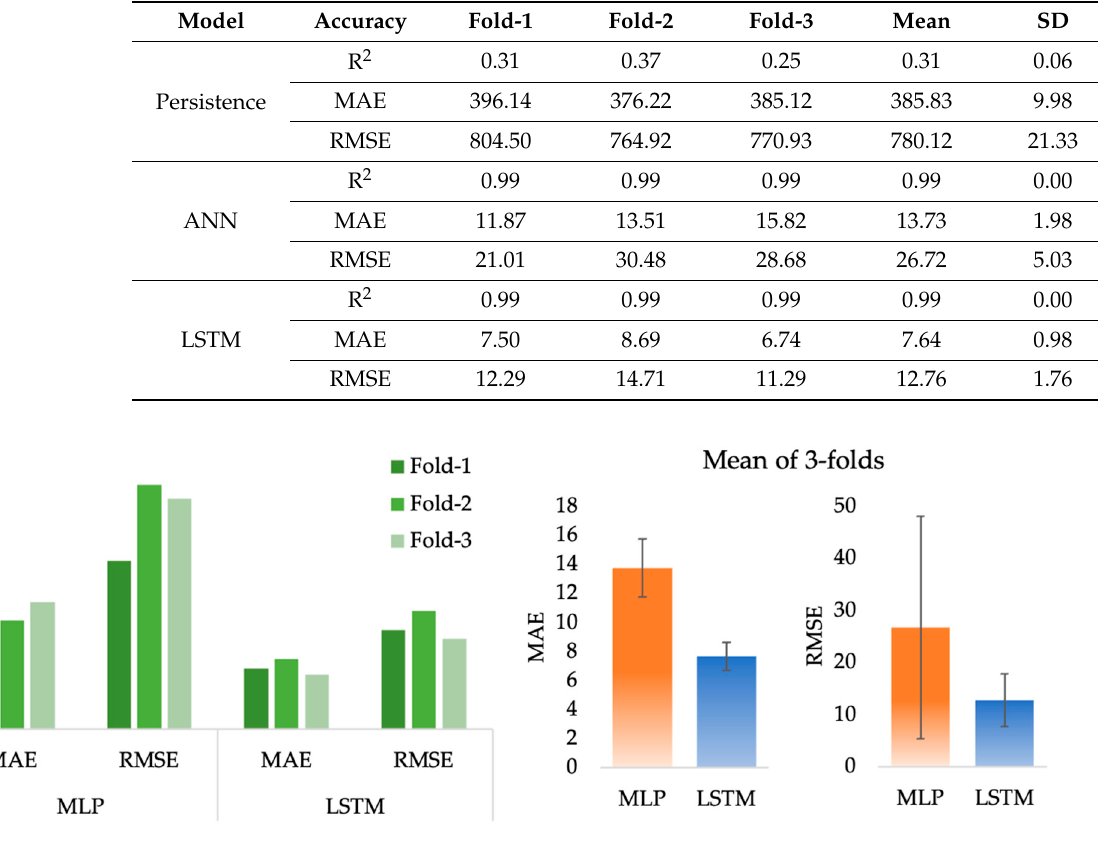
Figure 7. Accuracy results of MLP and LSTM models in each fold ( left ) . Mean errors of MAE and RMSE with standard deviation (SD) of MLP and LSTM models ( right ).